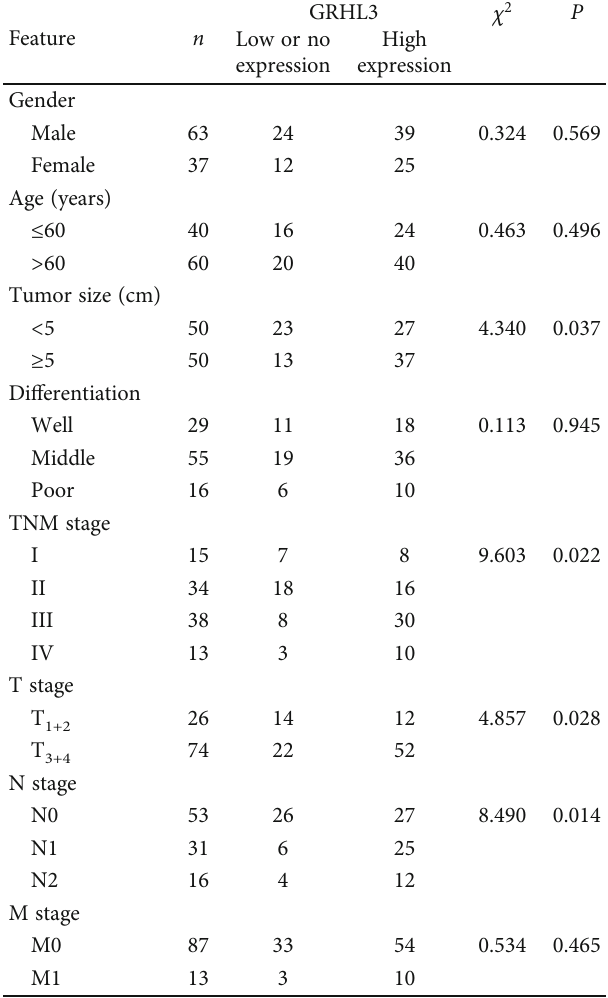
Table 1: Correlation analysis of GRHL3 expression and clinical characteristics of patients with